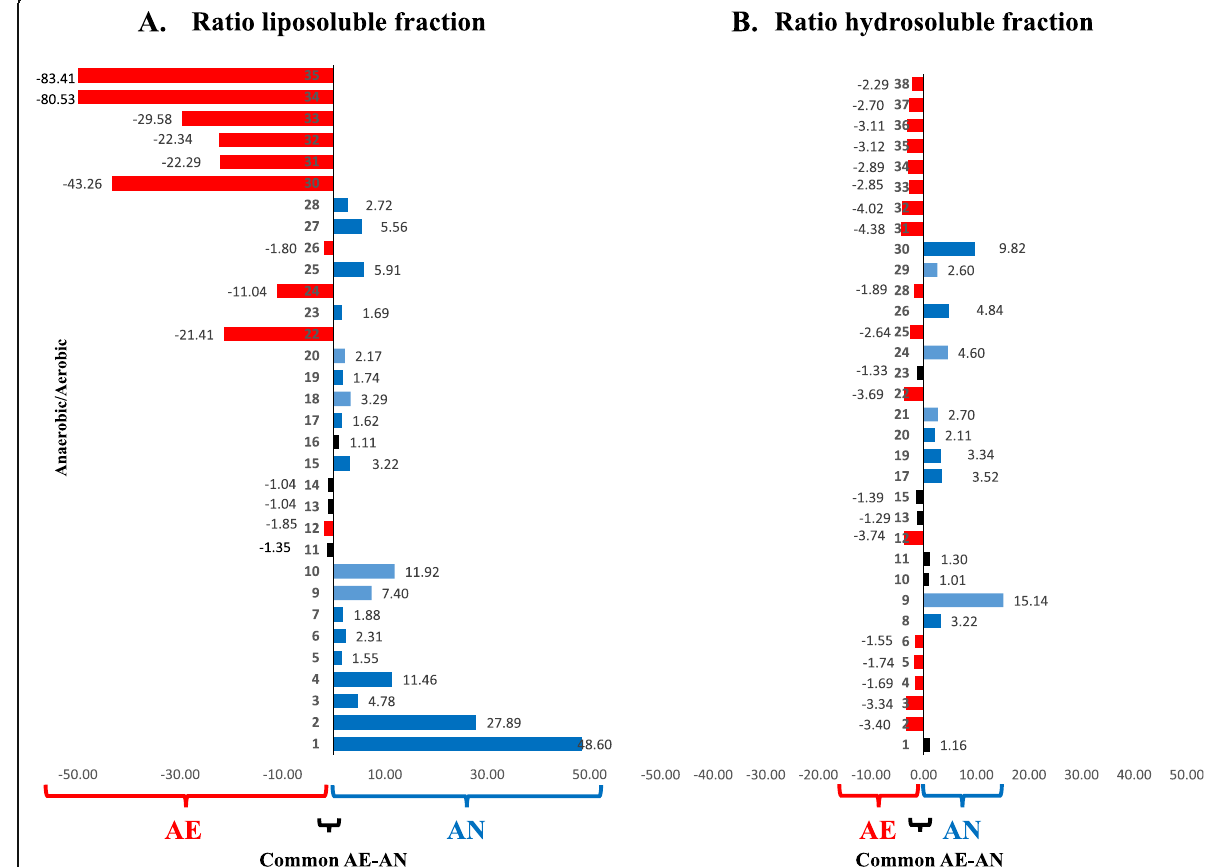
Fig. 3 Differentially expressed proteins in the liposoluble ( a ) and hydrosoluble ( b ) fractions obtained by 2D-Dige and MALDI-TOF/MS-MS analysis from Mycoplasma fermentans MFI grown in anaerobic conditions versus aerobic. The pick number from 1 to 35 for the liposoluble fraction and 1 – 38 for the hydrosoluble fraction, correspond to the proteins listed in Tables 1 and 2, respectively. A cut-off value of ±1.5 was used to distinguish between proteins similarly expressed in aerobic and anaerobic conditions ( − 1.5 ≤ ratio ≤ + 1.5) from proteins comparatively more expressed (ratio > + 1.5 and < − 1.5). When the same protein was found in both fractions, only the spot with higher ratio, where the protein was most represented, was included. In red are shown the proteins overexpressed in the fraction from aerobic condition, in blue are the proteins overexpressed in the fraction from anaerobic condition and in black are the proteins commonly found in both aerobic and